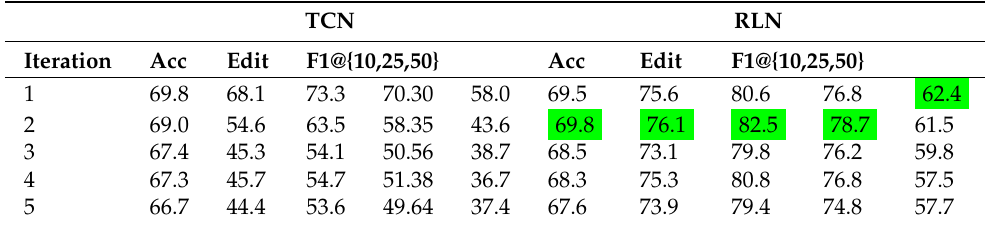
Table 9. RL-SSI in the Cereals